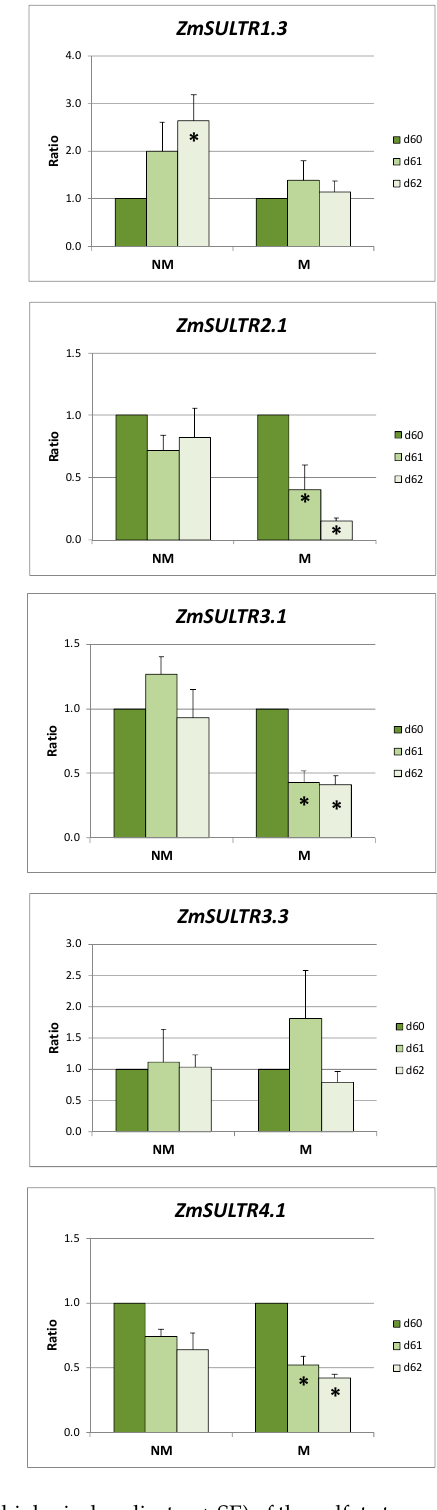
Figure 3. Relative expression ratios (the mean of six biological replicates ± SE) of the sulfate transporters in the leaves of non-mycorrhizal (NM) and mycorrhizal (M) maize plants before (left column) and after (right column) the supply of sulfate. d30/d45/d60/d61/d62: days after sowing. Significant differences ( p < 0.05) between the samples and the respective controls are represented by an asterisk (*).